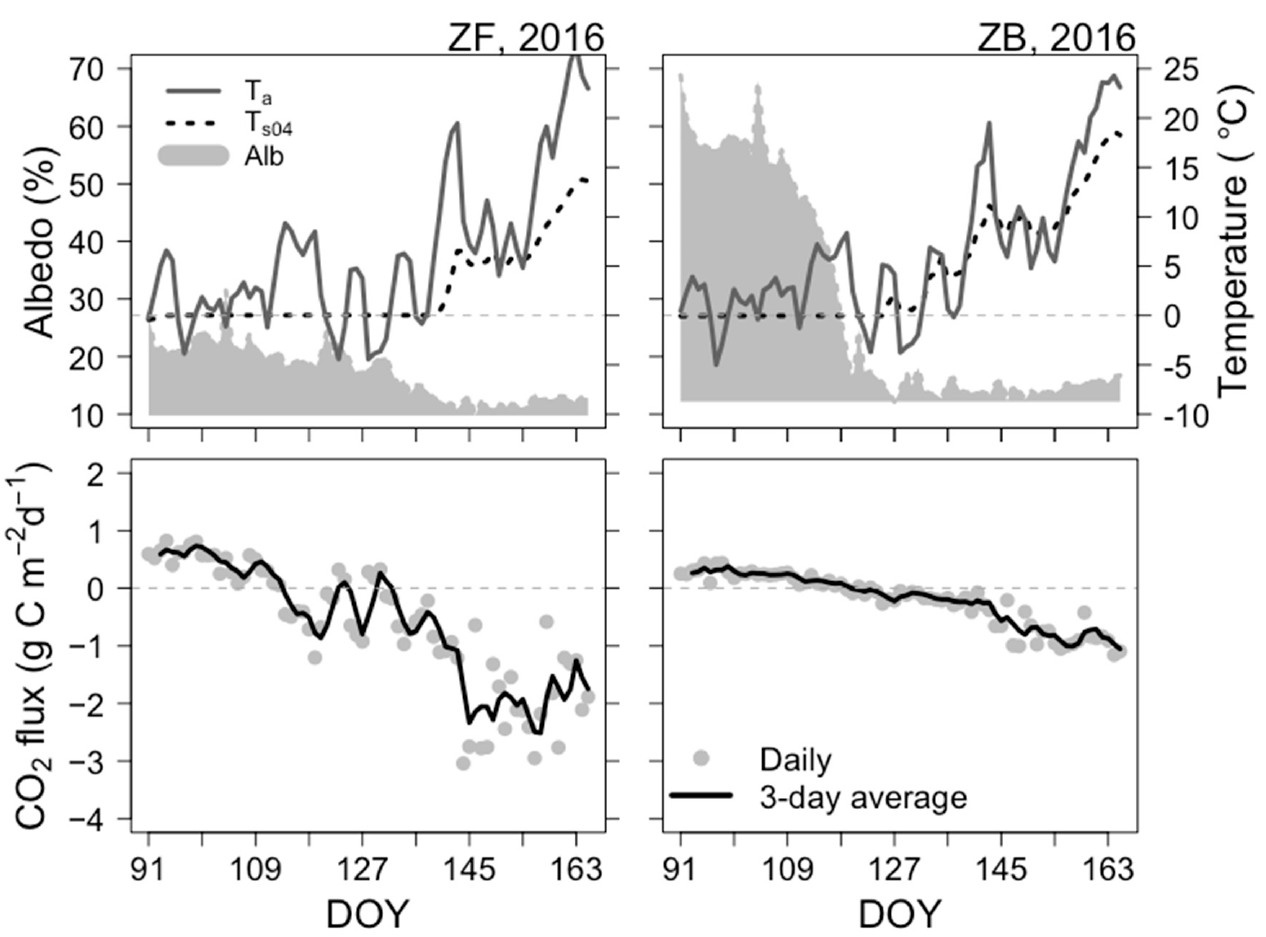
Figure 2. Time-series of three major environmental drivers and CO 2 flux for the period DOY 91–165 in 2016 at ZF and ZB sites. Upper panel: daily mean air temperature (T a , dark-grey line; unit: ◦ C), soil/peat temperature at 0.04 m (T s04 , dotted black line; unit: ◦ C), and albedo (Alb, grey-shaded area; unitless). Lower panel: daily net CO 2 flux (grey circle; unit: g C m − 2 d − 1 ) and 3-day moving average CO 2 flux (black line; unit: g C m − 2 d − 1 ). The dashed grey line denotes the zero-line of CO 2 flux, with positive CO 2 flux values indicating a net CO 2 source and negative values indicating a net CO 2 sink.